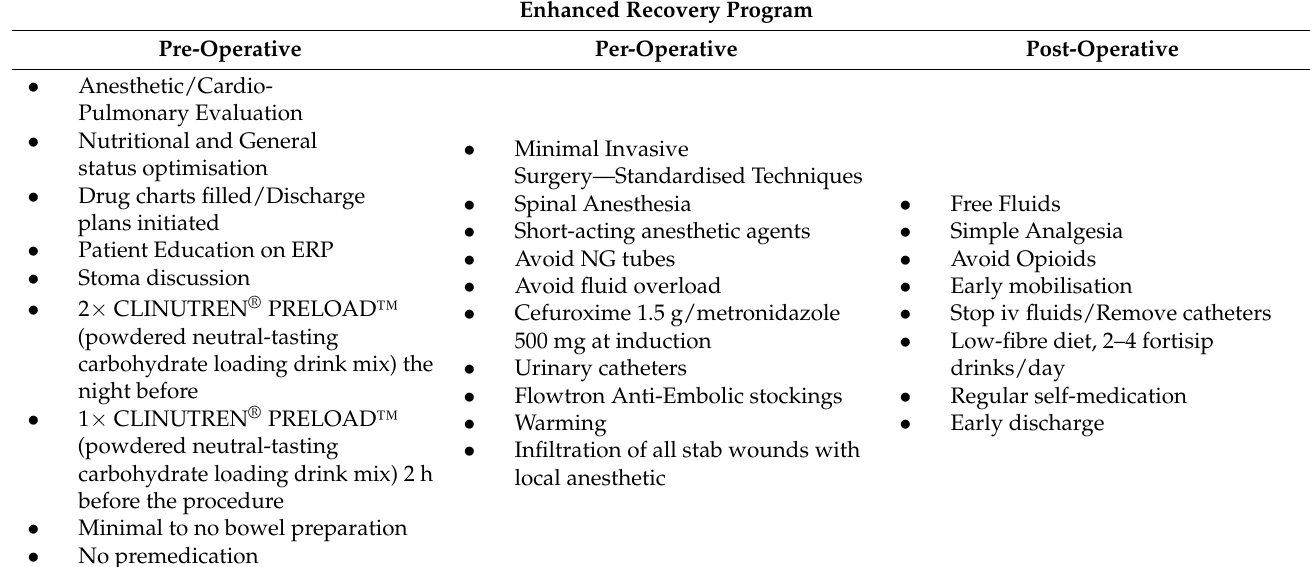
Table 1. Enhanced recovery